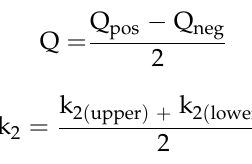
Figure 8. Comparison of force-displacement curves obtained for different shear strains, temperatures, and exposure times at a loading frequency of 0.5 Hz for ( a ) 100% and ( b ) 134% shear strains. In order to reveal the trend of change in isolator mechanical properties better, charac- teristic strength, Q, and post-elastic stiffness, k 2 (see Figure 9a for definitions) of the LRB were obtained using recorded force-displacement curves. Q and k 2 are calculated by the straight-line fit method suggested by EN-15129 [22]. In this study, the Least Square Method (LSM) is used to find the best fit for data by minimizing the sum of the squared errors. In Figure 9b, the application of LSM is described for a representative force-displacement curve. Accordingly, (Q pos and Q neg ) and (k 2(upper) and k 2(lower) ) values are acquired for each cycle of the motion as defined in Figure 9b. Then, the ultimate Q and k 2 values are computed by Equations (1) and (2), respectively. Tables 2 and 3 present the corresponding isolator characteristics calculated for different loading